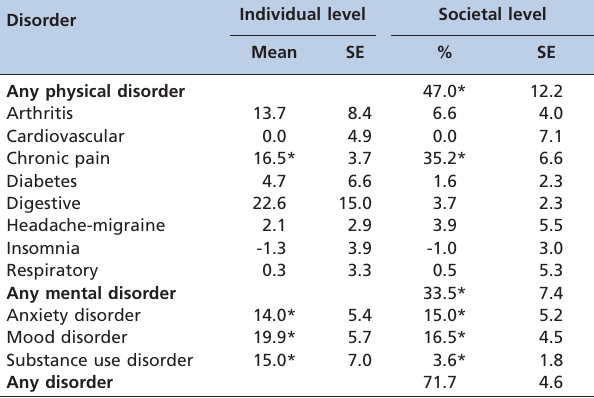
Table 4 - Simulated annual effects of each disorder on the number of days completely out-of-role at the individual 1 and societal levels. Data are from the Sa˜o Paulo Megacity Mental Health Survey (n=